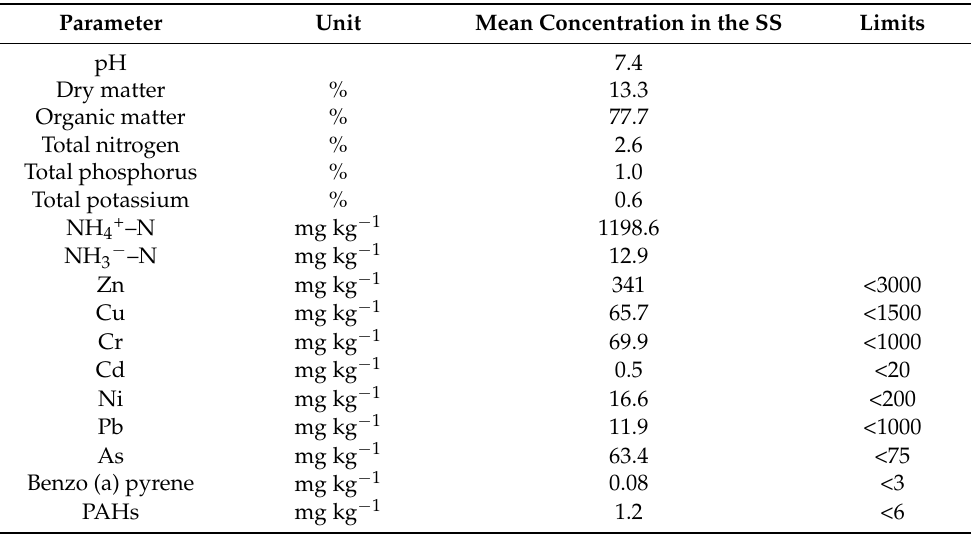
Table 1. Main chemical characteristics of sewage sludge (SS) and standard limits established in China regarding the quality of sludge used in forestland (CJ/T 362-2011). Parameter Unit Mean Concentration in the